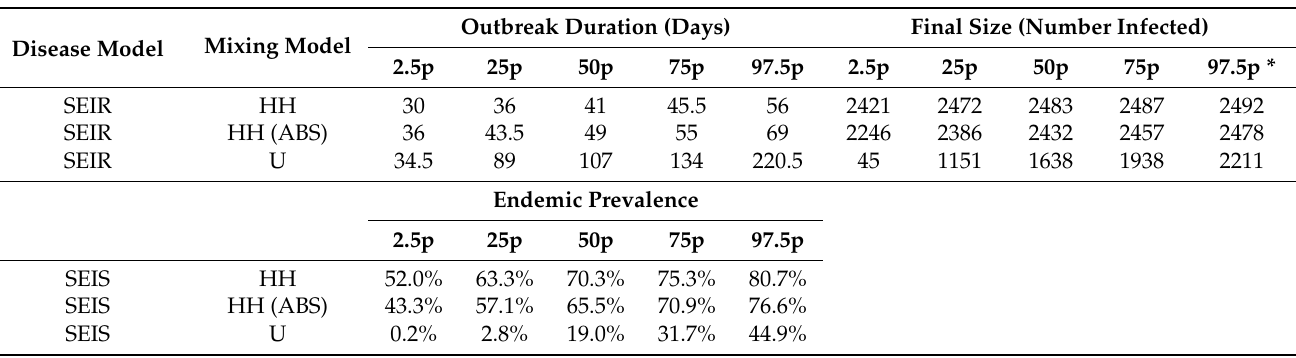
Table A5. Statistics from model scenarios of outbreaks and endemic disease for a community like the study community including total outbreak duration, attack rate and endemic